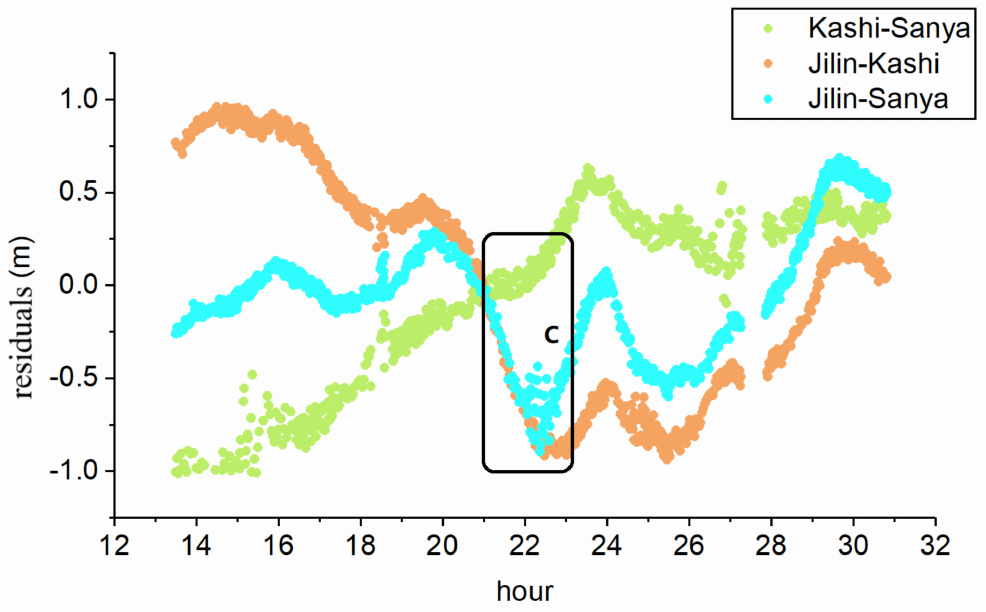
Figure 4. The result of checking VLBI data with long-arc orbit